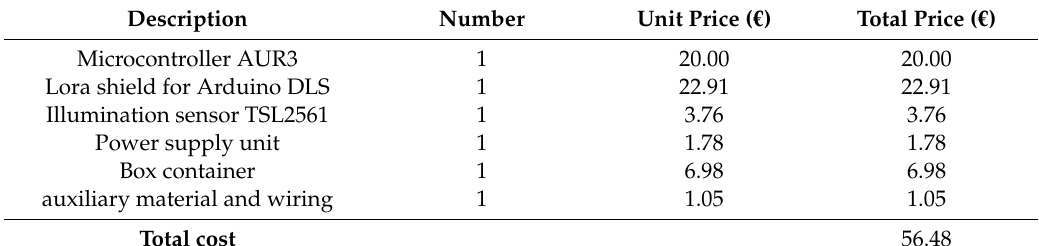
Table 5. LLMD components cost.